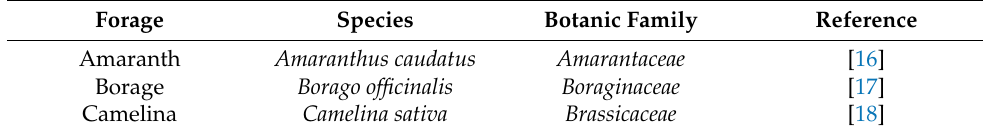
Table 1. Species, botanic family, and